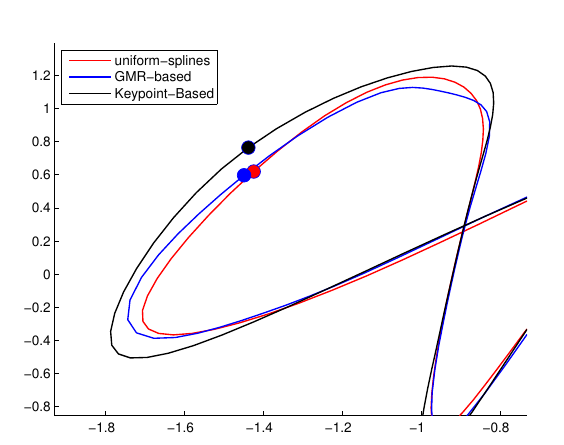
Figure 11. Benchmark of our proposed solution (keypoint-based) against an uniform-splines solution and a GMR solution for model 3. For the uniform-splines solution the knots are set equidistant, this opposed to our Key point-based solution. The GMR solution uses the same number of Gaussian clusters as discovered by our DPGMM method. For visibility reasons this figure zooms in on the top left part of the gesture. For convenience of the reader we added solid circles to all solutions indicating the position of the trajectories at the fourth beat. We notice that the key point-based solution excels in handling the temporal variation as it is better in preserving the extrema.